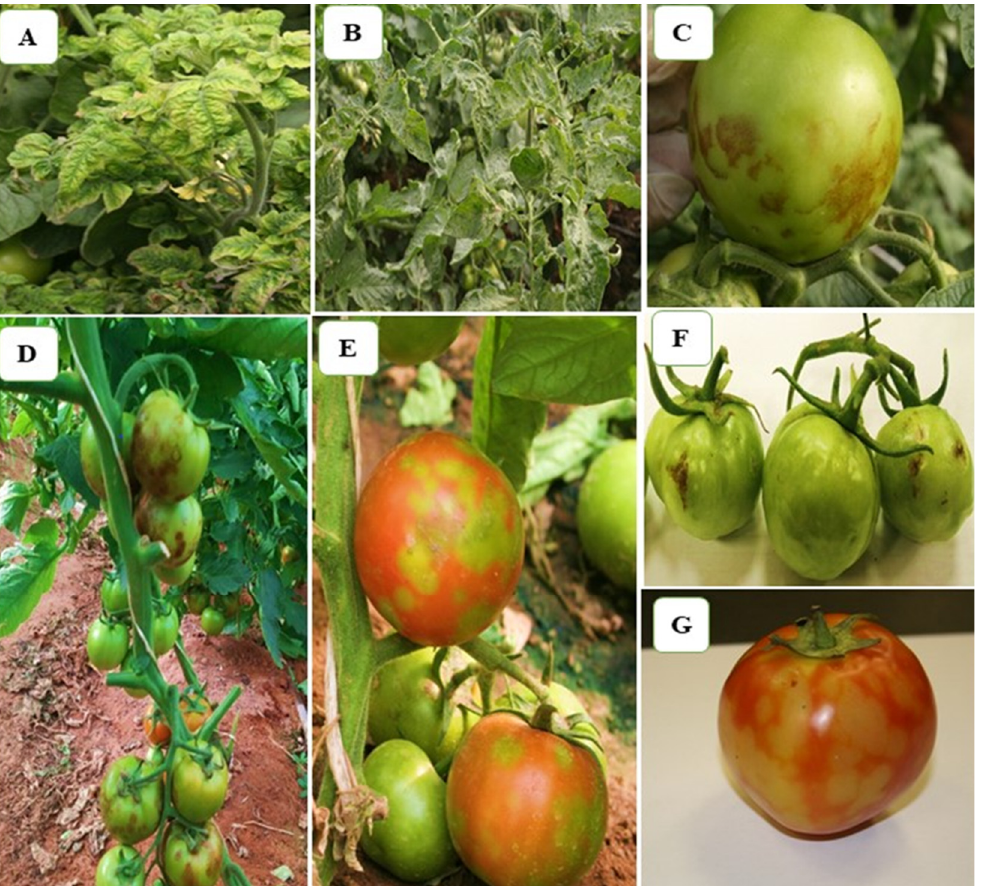
Figure 1. Symptoms of ToBRFV observed in different naturally infected tomato plants: ( A , B ) severe mosaic with dark green wrinkling, blistering, narrowing, and deformation on leaves; ( C , D ) irregular brown necrosis; ( E , G ) discoloration and yellow spots on fruits; ( F ) deformation on fruits.